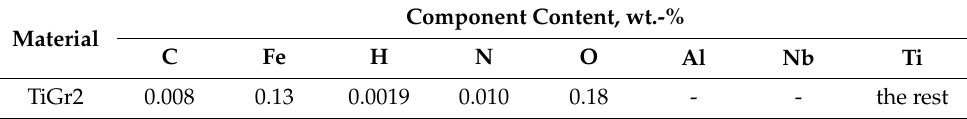
Figure 1. Microstructure of titanium Grade 2. Table 1. Chemical composition of titanium Grade 2 .